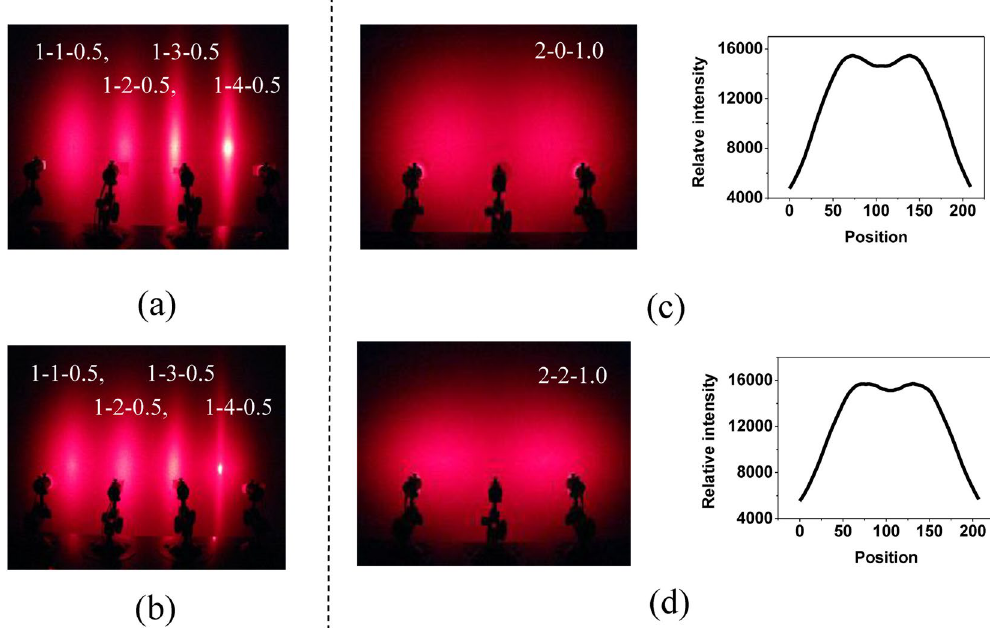
Figure 8. ( a ) and ( b ) The scattering patterns of the samples at different draw ratios when the OSB mass fraction is 0.5 wt%. ( c ) and ( d ) The two-source scattering effect of anisotropic and isotropic PC / SAN-OSB in the main scattering